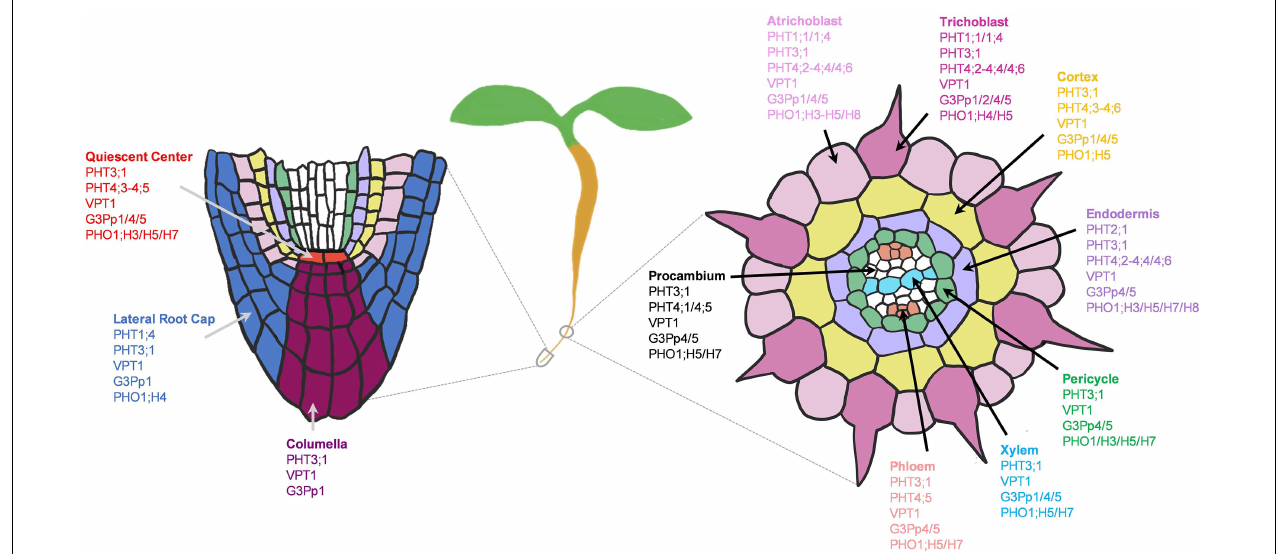
FIGURE 9 | Potential network of phosphate (Pi) transporters in the root system of 5–7 days old Arabidopsis seedlings grown under the normal growth conditions. Expressed Pi transporters involved in longitudinal transport (left) at the meristematic zone and radial transport (right) at the elongation/maturation zones were shown. Pi transporter genes not expressed under the normal growth conditions were